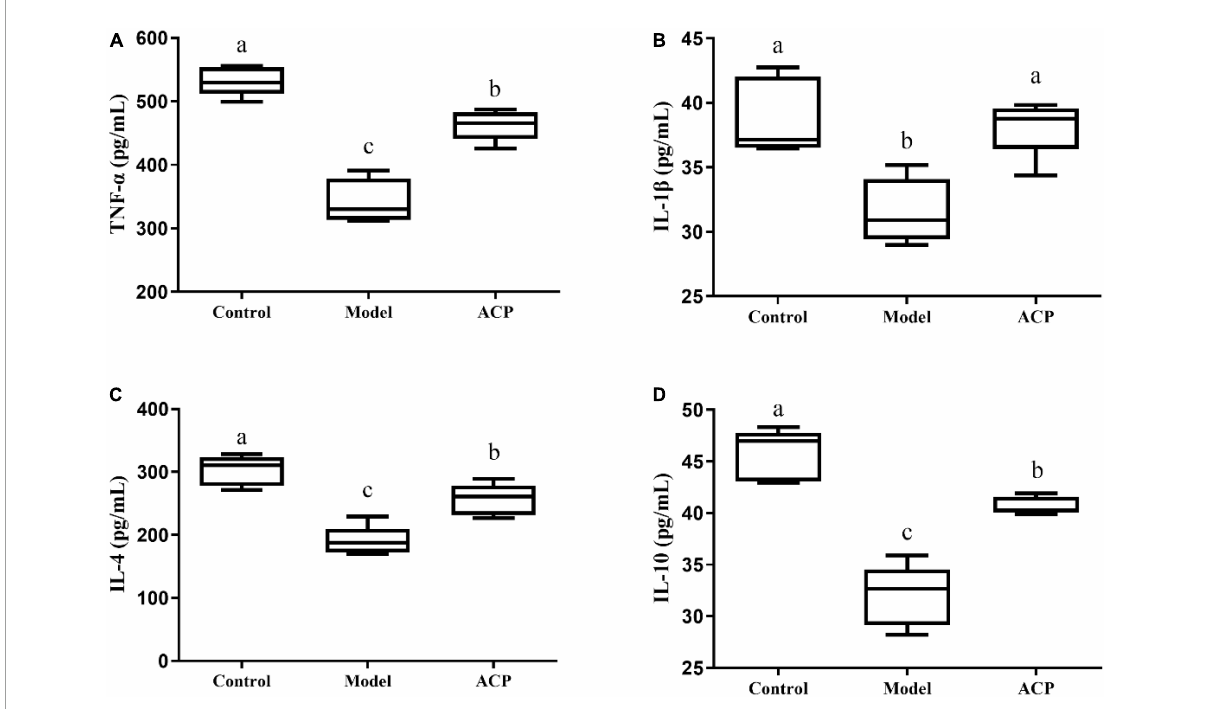
FIGURE3 Auricularia cornea var. Li. polysaccharides (ACP) supplementation on the levels of serum cytokine in immunosuppressed mice. (A) TNF- α , (B) IL-1 β , (C) IL-4, and (D) IL-10. Values are mean ± SD ( n = 6 independent experiment). Different superscript letters indicate significant differences ( P < 0.05) by using one-way analysis of variance, followed by Duncan’s test.